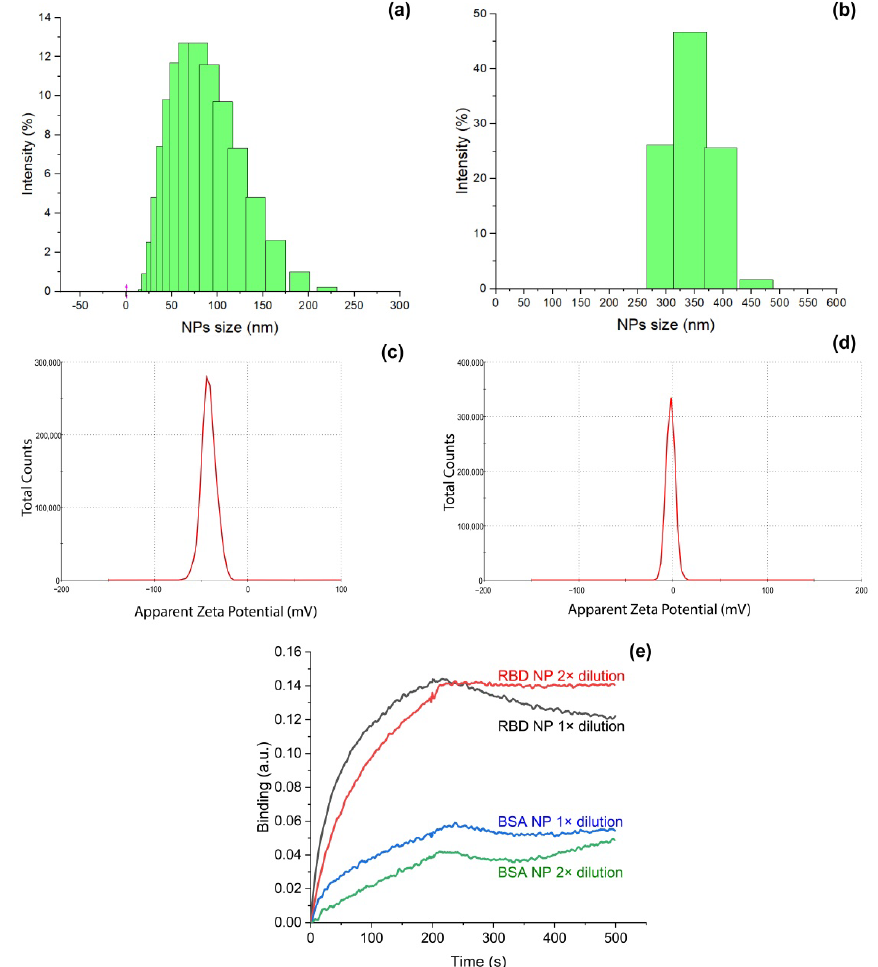
Figure 2. The size distribution for unmodified nanoparticles ( a ) and RBD-coated nanoparticles ( b ) estimated with dynamic light scattering. ζ -potential of unmodified nanoparticles ( c ) and RBD- coated nanoparticles ( d ) estimated with dynamic light scattering. ( e ) Interaction between aptamer RBD-1C and silver nanoparticles coated with RBD or BSA proteins.